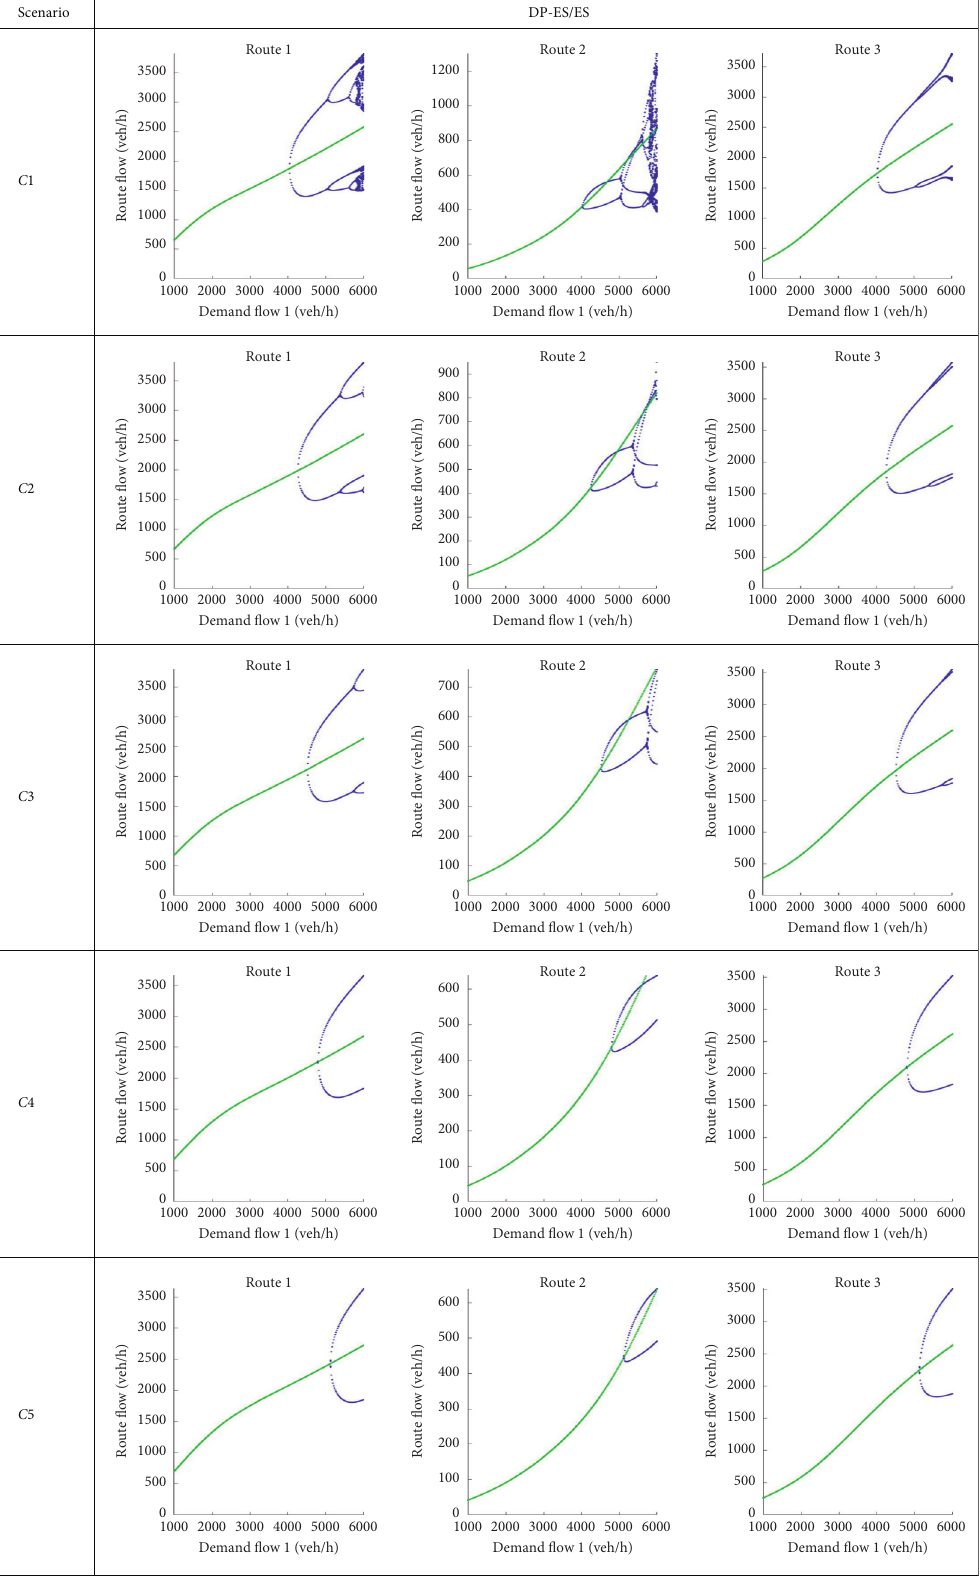
Figure 5: Bifurcation demand flow, AVs scenarios C: θ